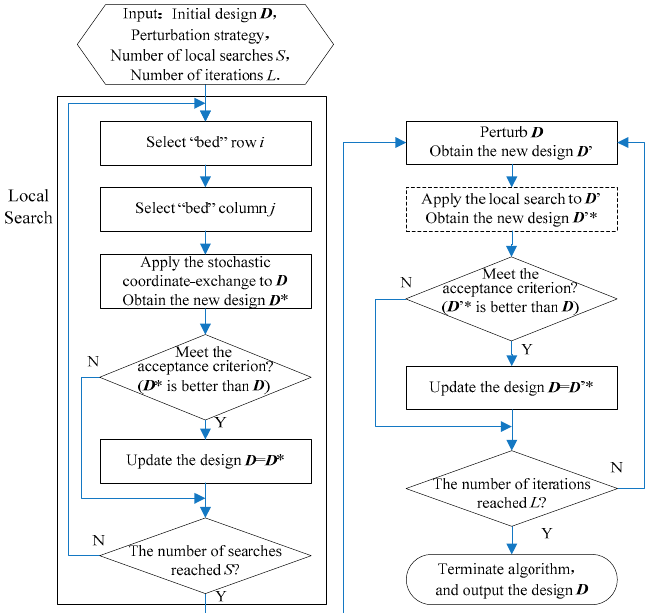
Figure 1. Flow chart of the iterated perturbation.